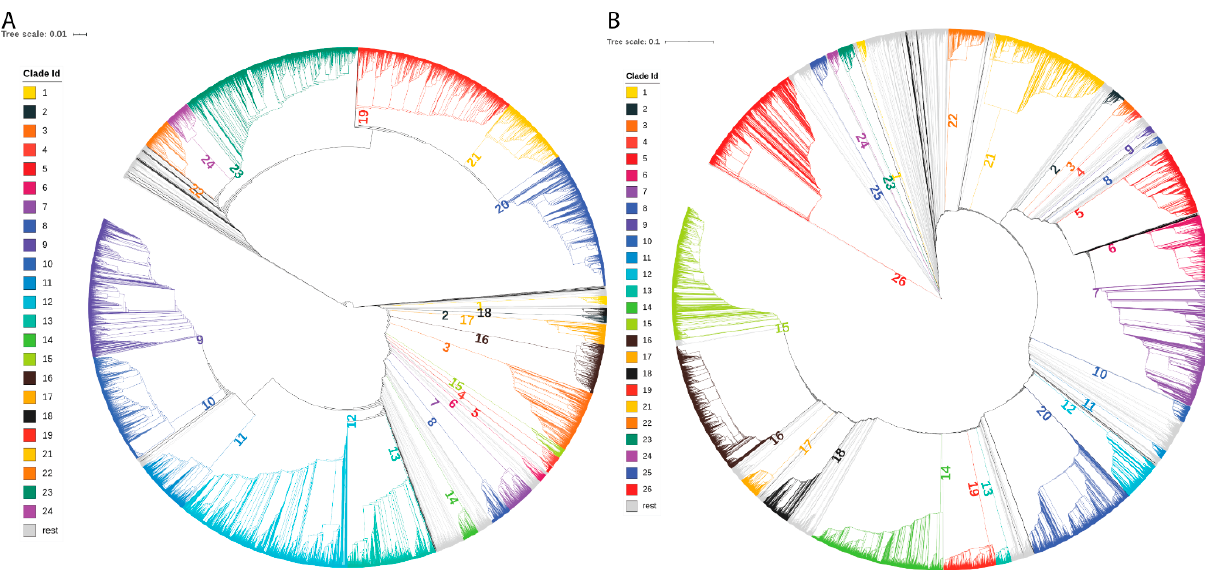
Figure 1. Phylogenetic analysis results. ( A ) Phylogenetic tree from the GenBank dataset. ( B ) Phylogenetic tree from the GISAID dataset. The major clades are marked in colors and labeled with numbers.